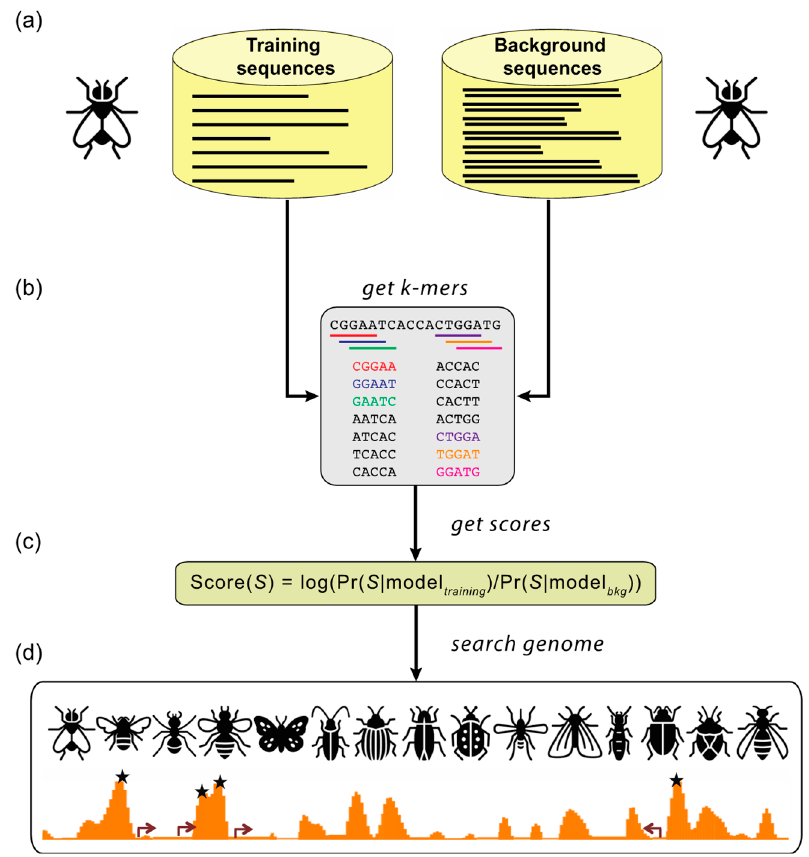
Figure 2. Supervised motif-blind CRM discovery (SCRMshaw). ( a ) SCRMshaw uses a training set of known Drosophila melanogaster CRMs (“training sequences”), drawn from REDfly, that are defined by common functional characterization, and a 10-fold larger background set of similarly sized non-CRM sequences (“background sequences”). ( b ) The short DNA subsequence ( kmer ) count distributions of these sequences are then used to train a statistical model. The trained model ( c ) is used to score overlapping windows in the “target genome”; to date, we have successfully used multiple different species from the Holometabola and several Hemiptera. ( d ) High-scoring regions are predicted to be functional regulatory sequences (asterisks). Figure adapted from [69]. Insect images downloaded from TheNounProject.com (accessed on 28 April 2021) set “Bugs” by Georgiana Ionescu, under the CC-BY